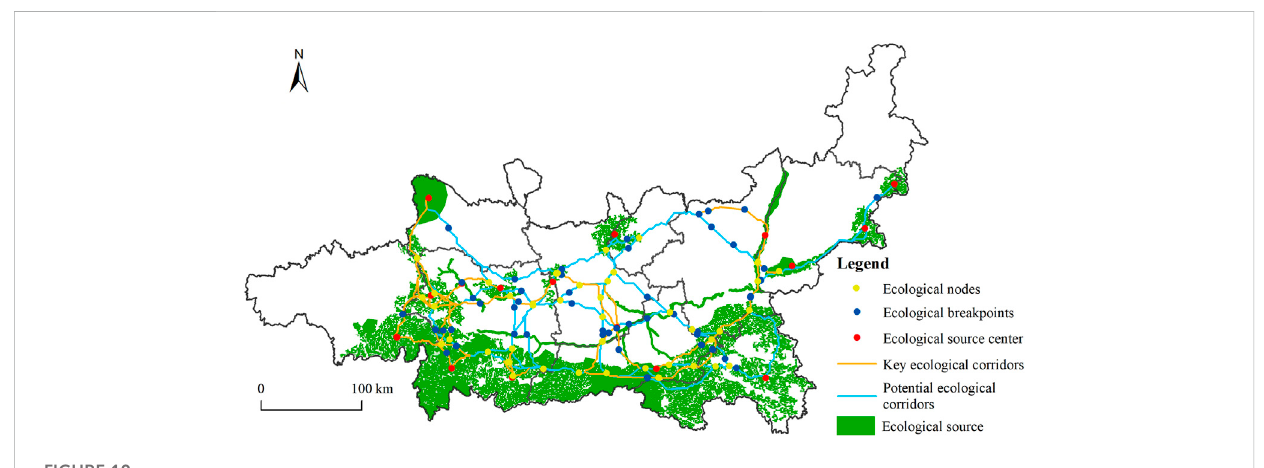
FIGURE 10 Ecological security pattern (ESP) in